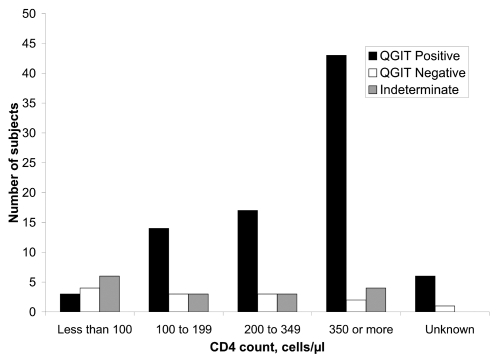
Distribution of QuantiFERON-TB® Gold In-Tube results by CD4+ lymphocyte count.Proportion of both negative and indeterminate results increased with falling CD4+ lymphocyte count. QGIT, QuantiFERON-TB® Gold In-Tube.